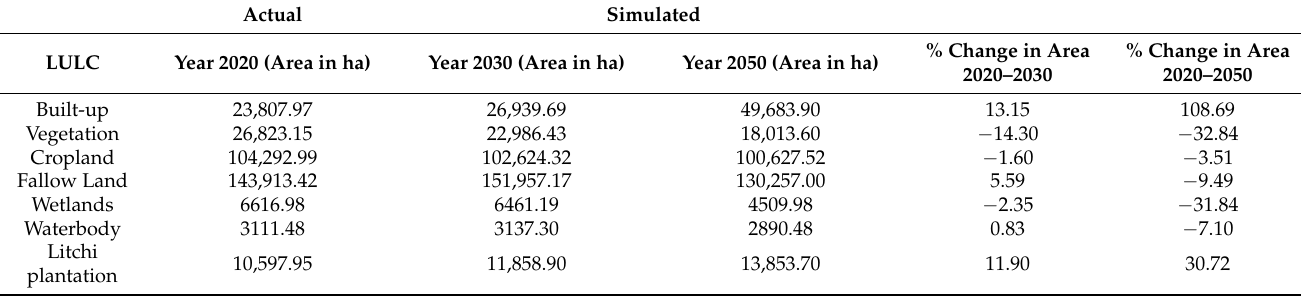
Figure 9. ( a , b ) Predicted LULC maps for the years 2030 and 2050. Table 7. Area estimates of predicted LULC in hectares. Actual